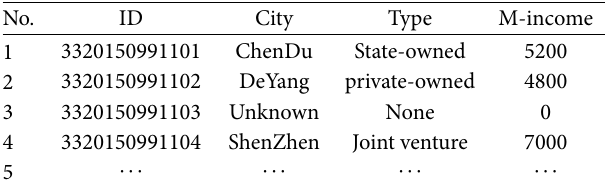
Table 2: Graduate employment